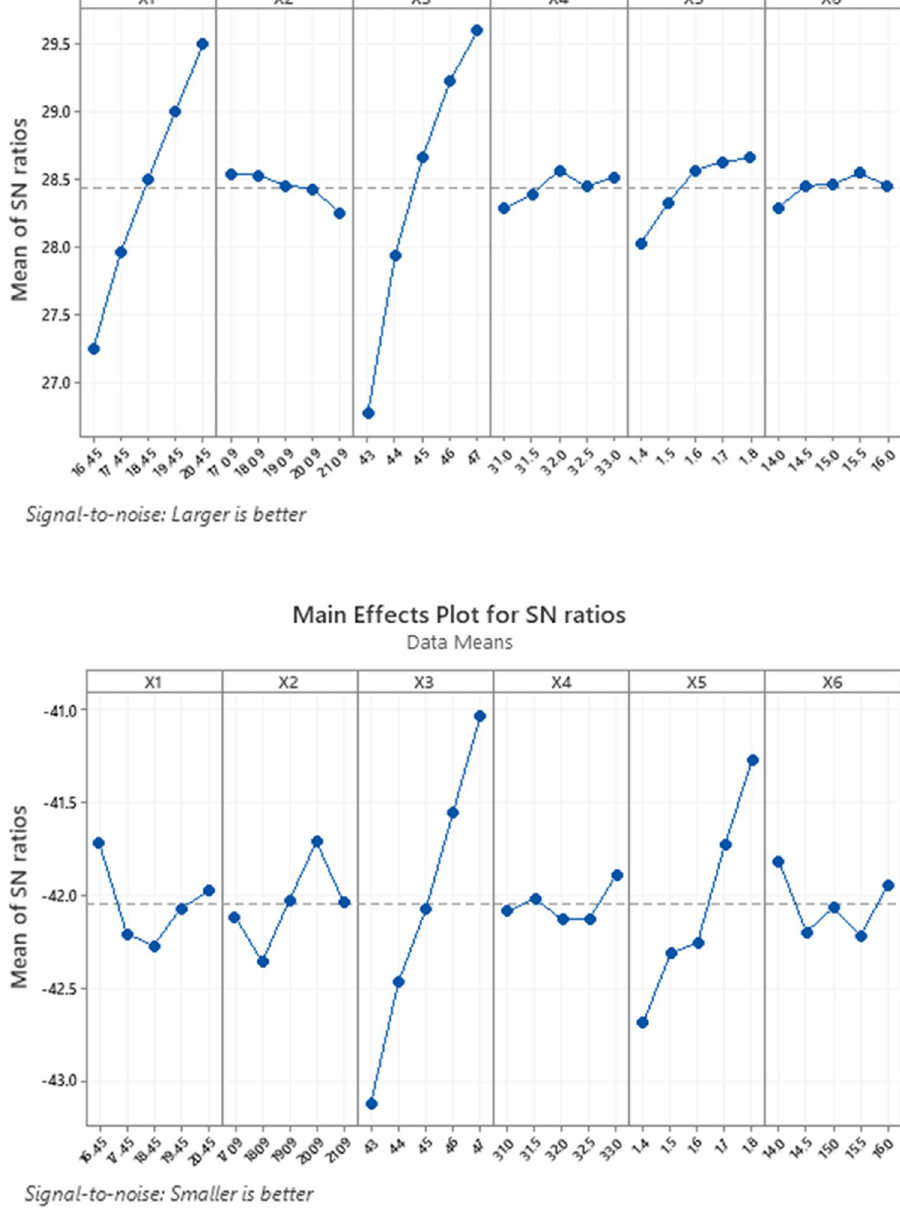
Fig. 7 Main effects plot for S / N ratio (AF), larger is better